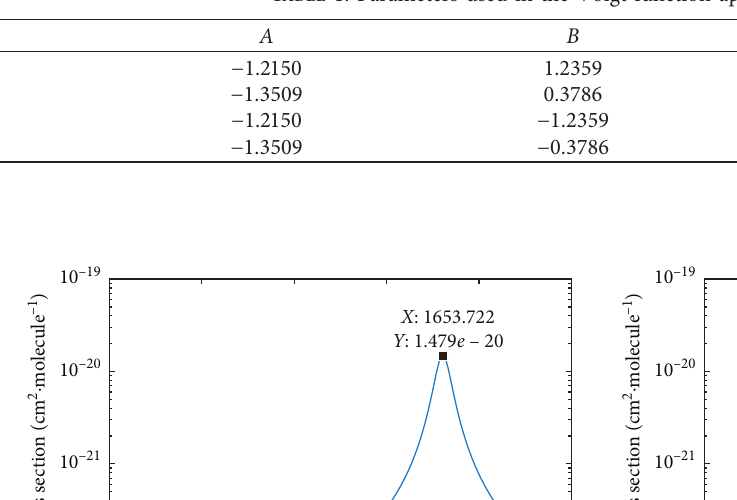
Table 1: Parameters used in the Voigt function approximation method.